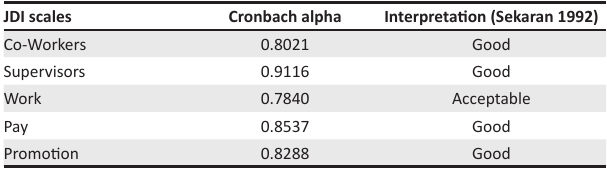
TABLE 2: Cronbach alpha scores for JS - Smith et al. (1969) JDI. JDI